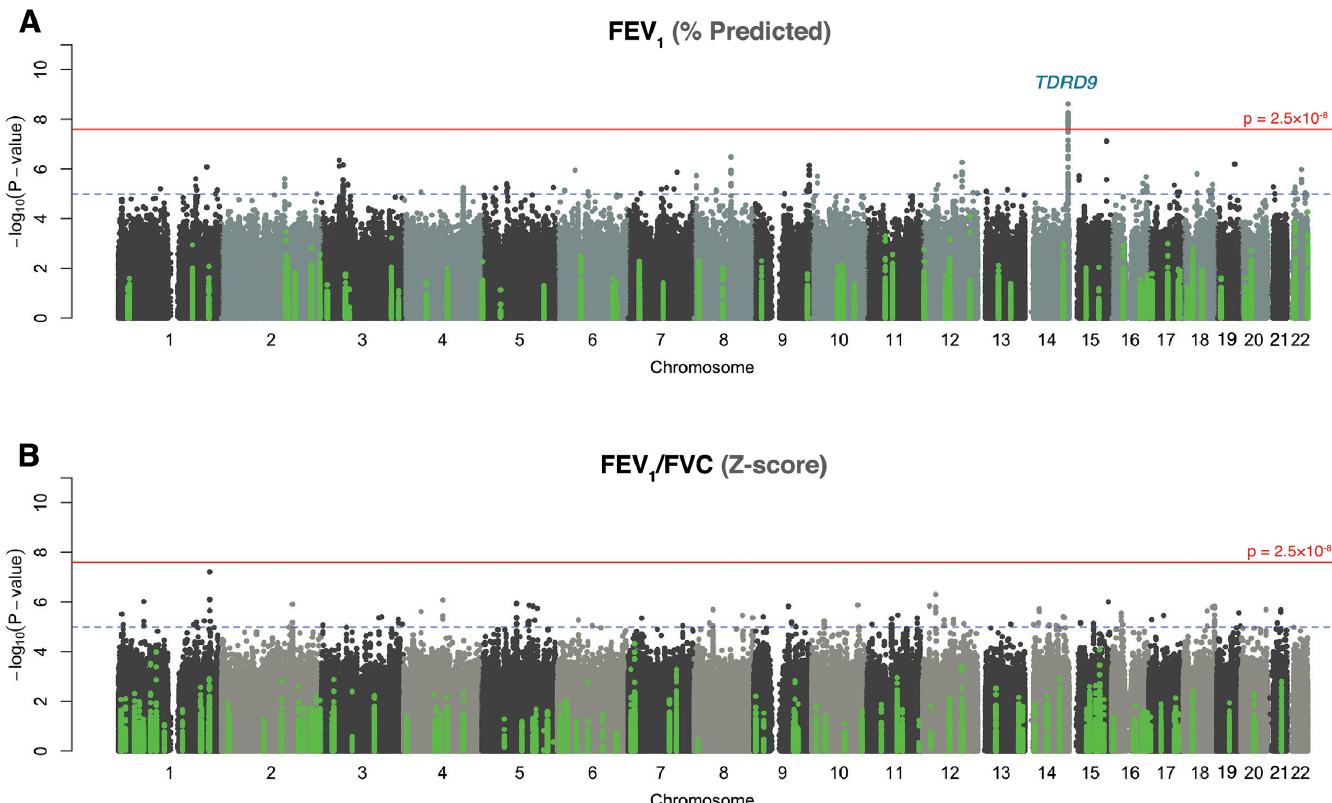
Fig 2. Genome-wide association results. GWAS Manhattan plots for A) FEV 1 and B) FEV 1 /FVC ratio. The horizontal red line indicates genome-wide significance (p � 2.5x10 − 8 ). The dotted horizontal blue line indicates p = 1x10 − 5 . Variants colored in green are in previously identified GWAS loci [23]. FEV 1 , forced expiratory volume in one second; FEV 1 /FVC, ratio of FEV 1 to forced vital